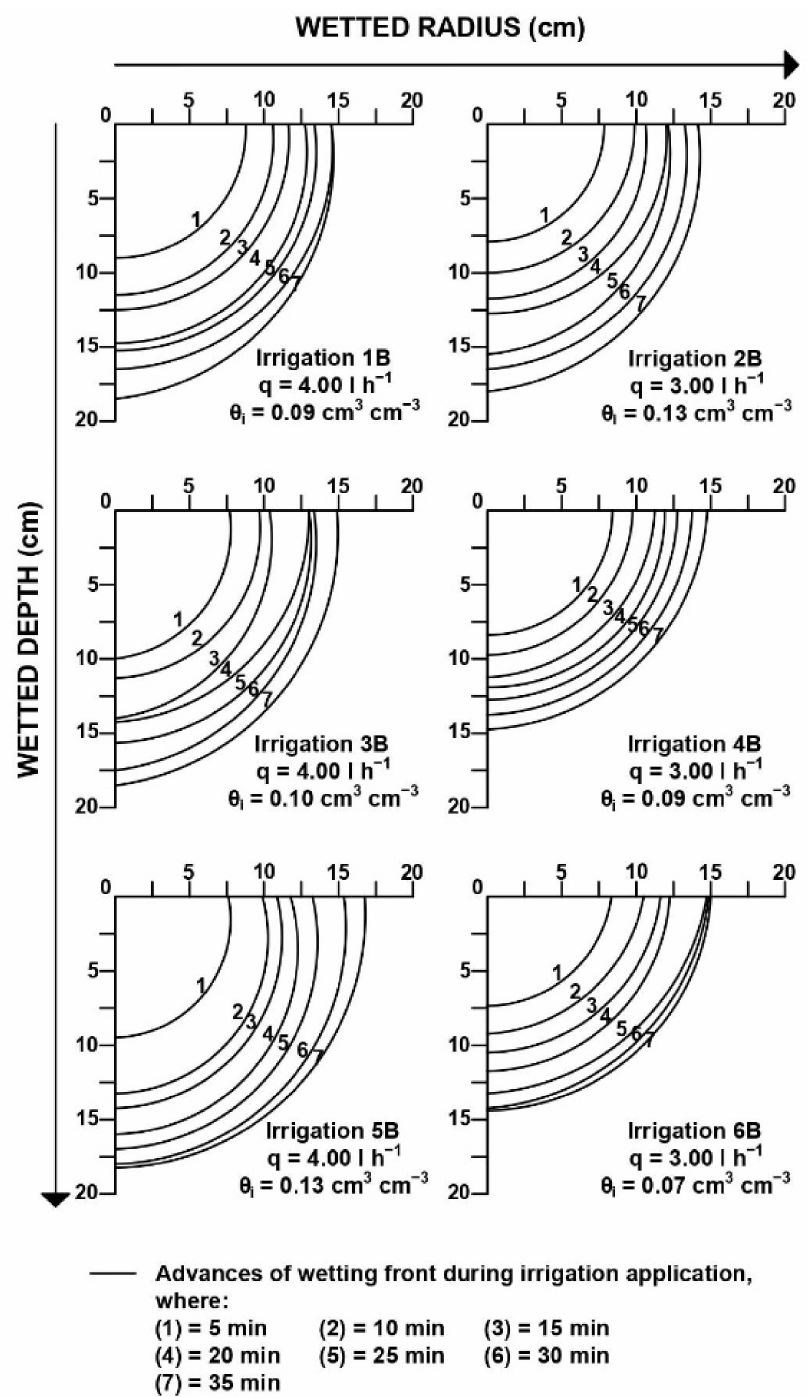
Figure 5. Geometry of the wetting front as a function of irrigation time in the second irrigation